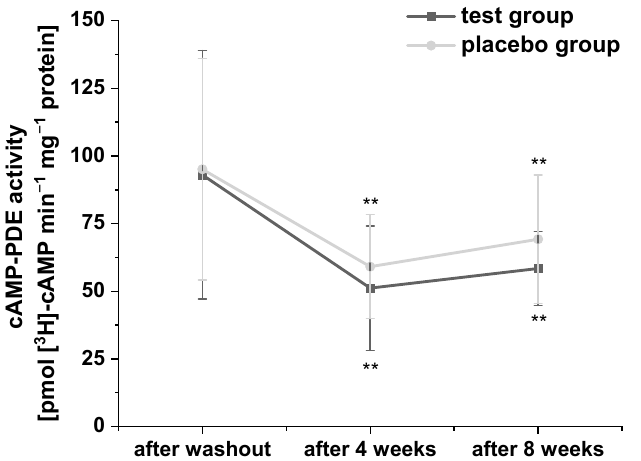
Figure 2. The modulation of cyclic adenosine monophosphate (cAMP)-phosphodiesterase (PDE) activity in the platelets of subjects. Values are expressed as means ± SD. Data were normalized to protein content and expressed in units of cAMP-PDE activity (pmol cAMP min − 1 mg − 1 protein). Significant differences in comparison to the washout period: ** p < 0.01.